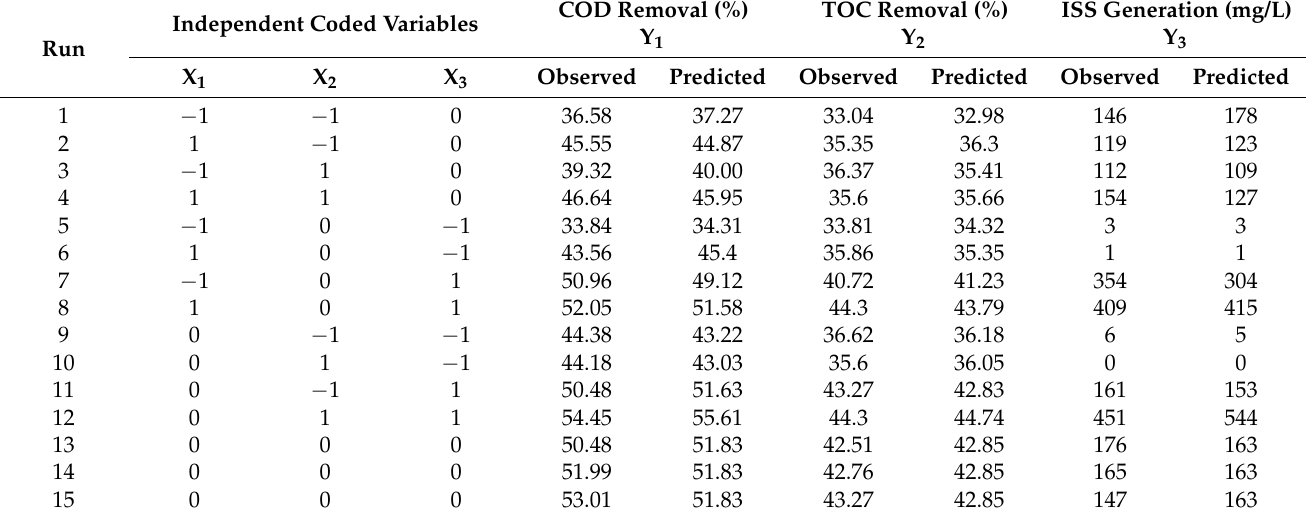
Table 3. Observed and predicted COD removal, TOC removal, and ISS generation for the three- factor BBD used to assess performance of the Fenton-like process for the treatment of actual WWW pre-treated via dilution and